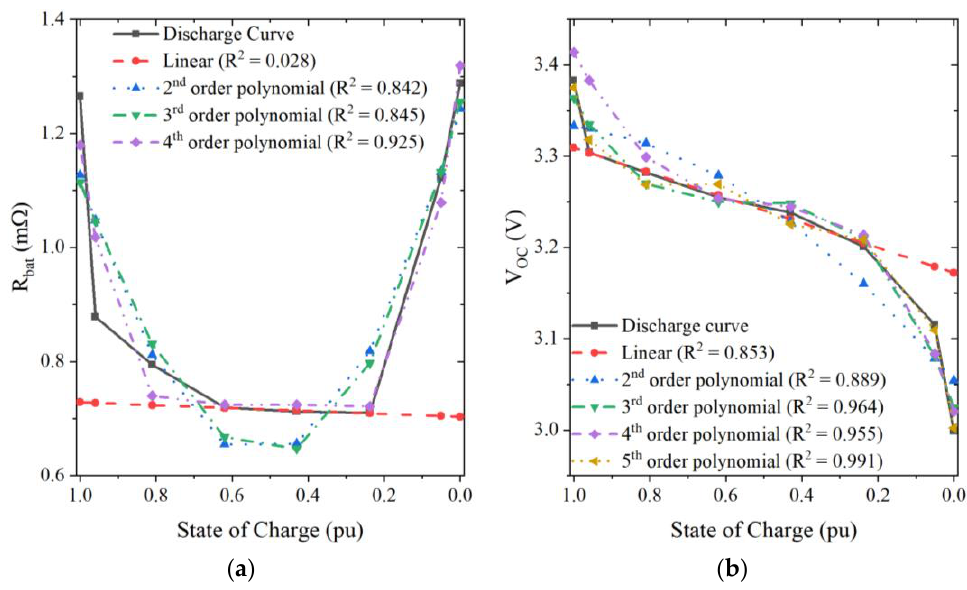
Figure 5. Polynomial curve fittings: ( a ) internal series resistance; ( b ) open-circuit voltage.